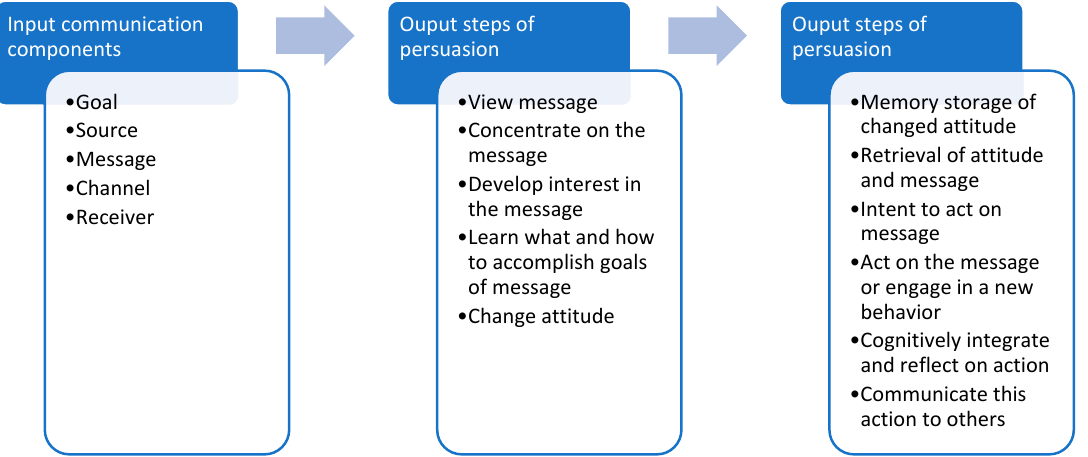
Figure 1. McGuire’s Communication and Persuasion Matrix (Adapted from McGuire, 2013).